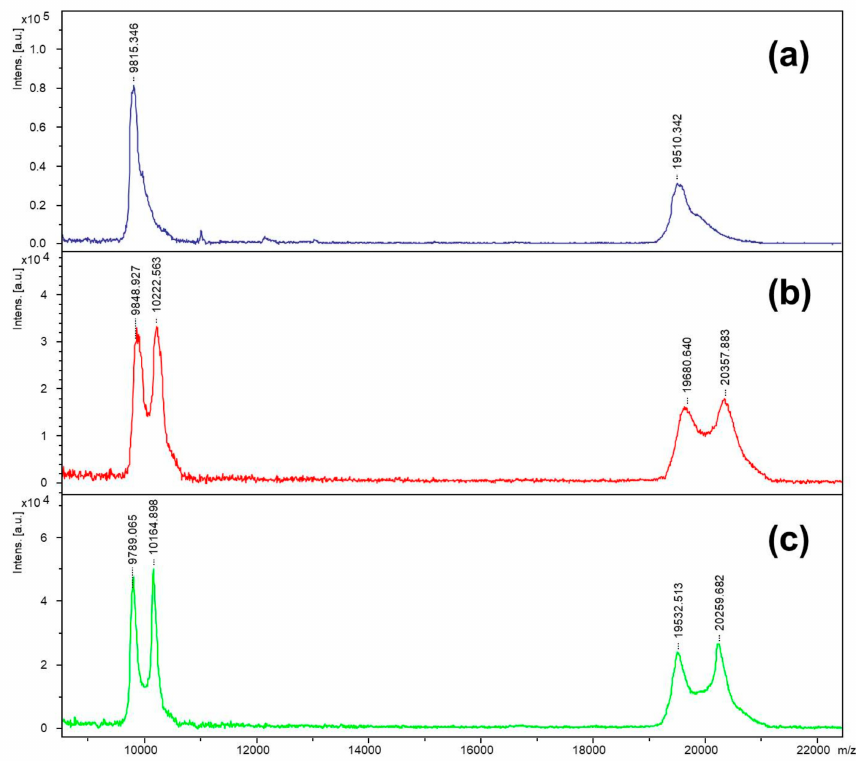
Figure 5. MADI-TOF spectra of ( a ) staphopain C; ( b ) biotinylated inhibitor after incubation with staphopain C at pH 5.0; ( c ) biotinylated inhibitor after incubation with staphopain C at pH